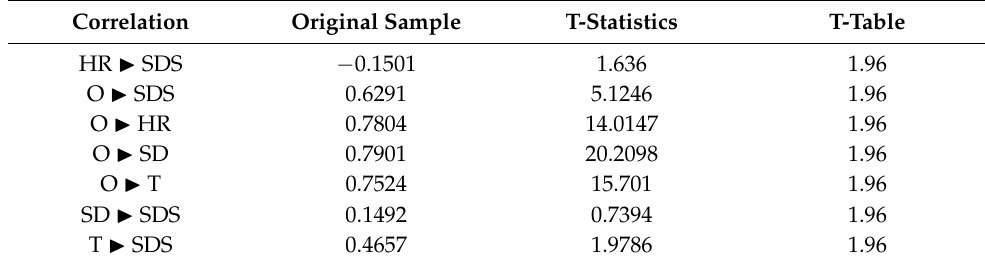
Table 11. Bootstrapping result of partial least